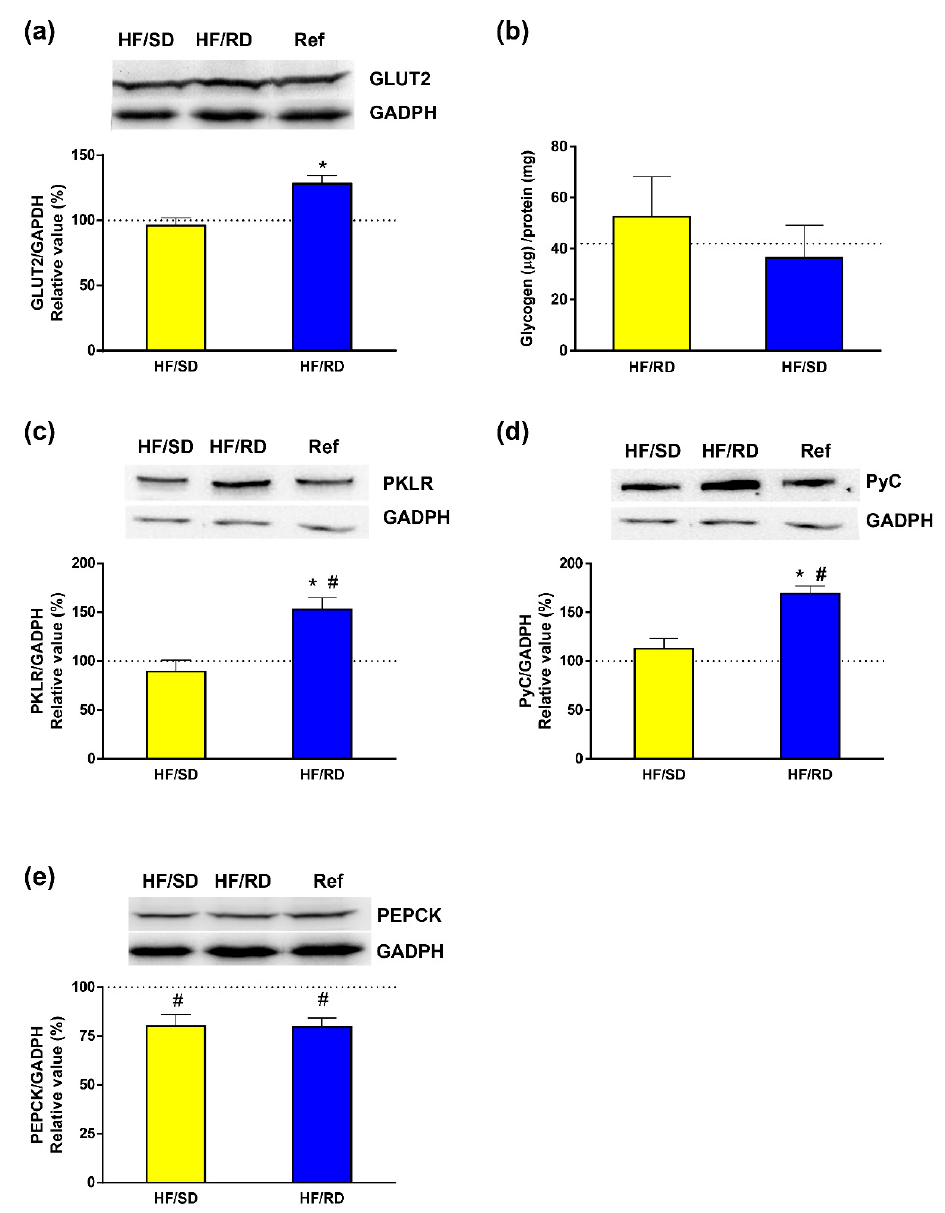
Figure 4. Liver carbohydrate metabolism. The expression of relevant transporters and enzymes has been analyzed by western blot; liver glycogen content has been assayed enzymatically. ( a ) GLUT2 transporter. ( b ) Glycogen content. ( c ) Liver pyruvate kinase isoenzyme (PKLR). ( d ) Pyruvate carboxylase (PyC). ( e ) Phosphoenol pyruvate carboxykinase (PEPCK). Results have been referred to reference rats (100% value). Results are mean ± SEM ( n = 6 animals per group). * p < 0.05 compared to the HF–SD group; # p < 0.05 compared to the reference